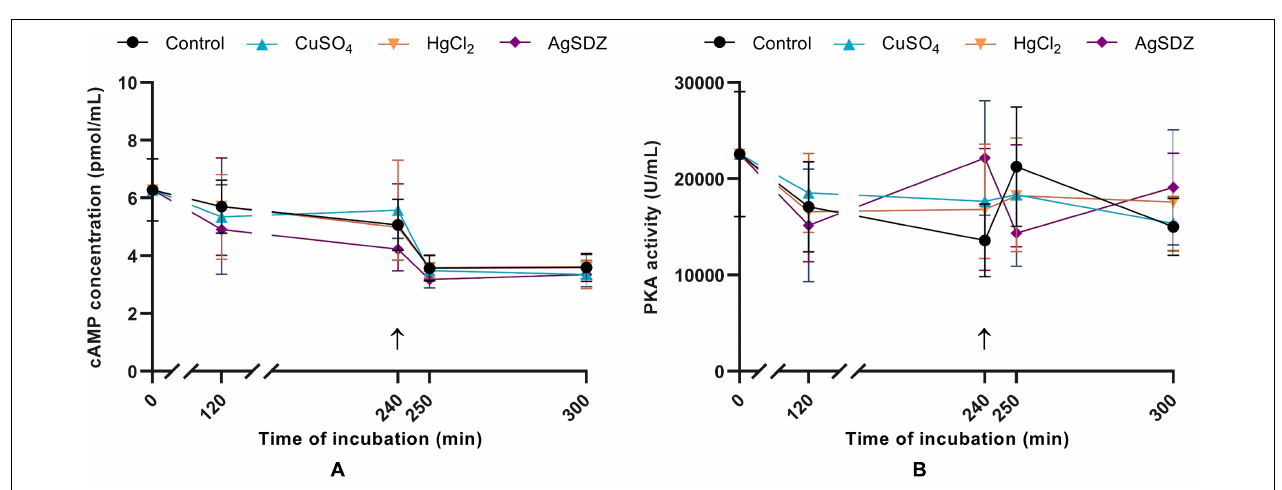
FIGURE 6 | Intracellular concentration of cAMP and PKA activity. (A) Intracellular concentration of cyclic AMP (cAMP) in sperm cells (pmol/mL) and (B) PKA intracellular activity (U/mL) in samples exposed to the presence or absence of different AQP inhibitors in the capacitation medium: cooper sulfate (CuSO 4 ), mercury chloride (HgCl 2 ) and silver sulfadiazine (AgSDZ). Data were collected after 0, 120, and 240 min of incubation in capacitation medium. At this point, progesterone was added to capacitation medium (arrow) and data were collected after further 10 and 60 min of incubation. Data are shown as mean ± SEM, and different letters (a,b) indicate significant differences ( P < 0.05) between different treatments within a given time